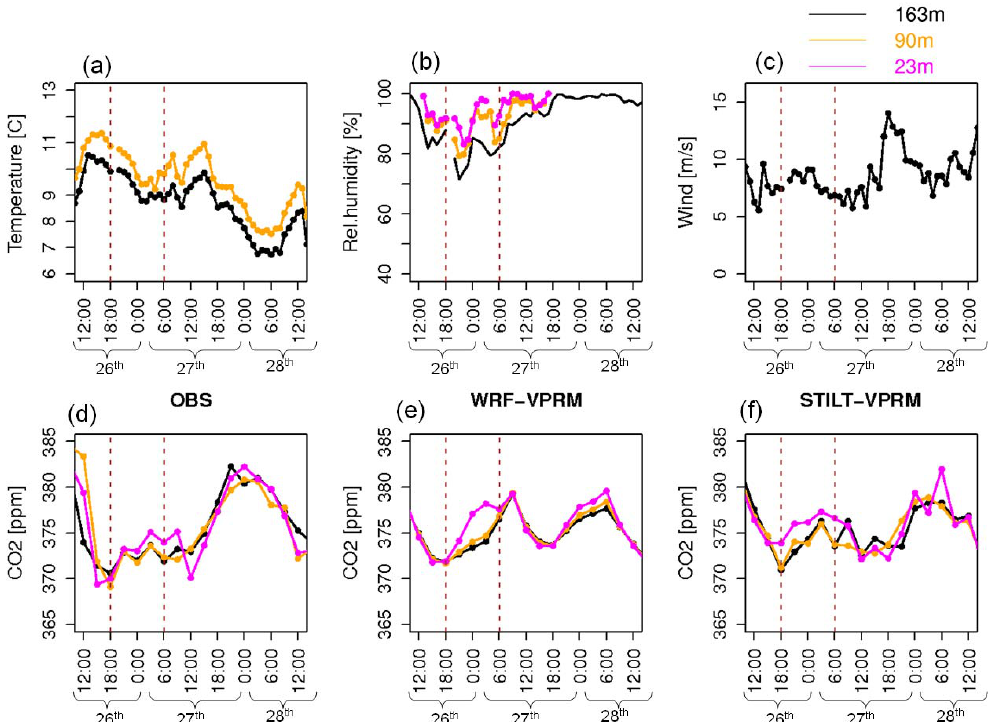
Fig. 9. Time series of meteorological parameters and CO 2 concentrations for different levels at OXK site during 26–28 August 2006: Figure 9. Time series of meteorological parameters and CO concentrations for different (a–c) observed air-temperature, relative humidity and wind speed respectively (d–f) CO 2 concentration, observed and modeled by WRF and 2 STILT, respectively. The area between dashed brown vertical bars denotes the period under mountain-valley circulation. The x-axis shows levels at OXK site during 26-28 August 2006: a-c) observed air-temperature, relative hours in UTC; the horizontal extent of curly bracket at the bottom of x-axis shows the day on August 2006. humidity and wind speed respectively d-f) CO concentration, observed and modeled by 2 WRF and STILT, respectively. The area between dashed brown vertical bars denotes the cooling of the surface on 26 August, relatively dry air in- truded from the free troposphere into the nocturnal boundary period under mountain-valley circulation. The X-axis shows hours in UTC; the horizontal layer, which was observed as a sharp decrease in the rela- tive humidity (Fig. 9b). Noticeable time lags in the transi- extent of curly bracket at the bottom of X-axis shows the day on August 2006. tion from moist to dry air were seen at the different sampling levels, which also indicate the intrusion of air from